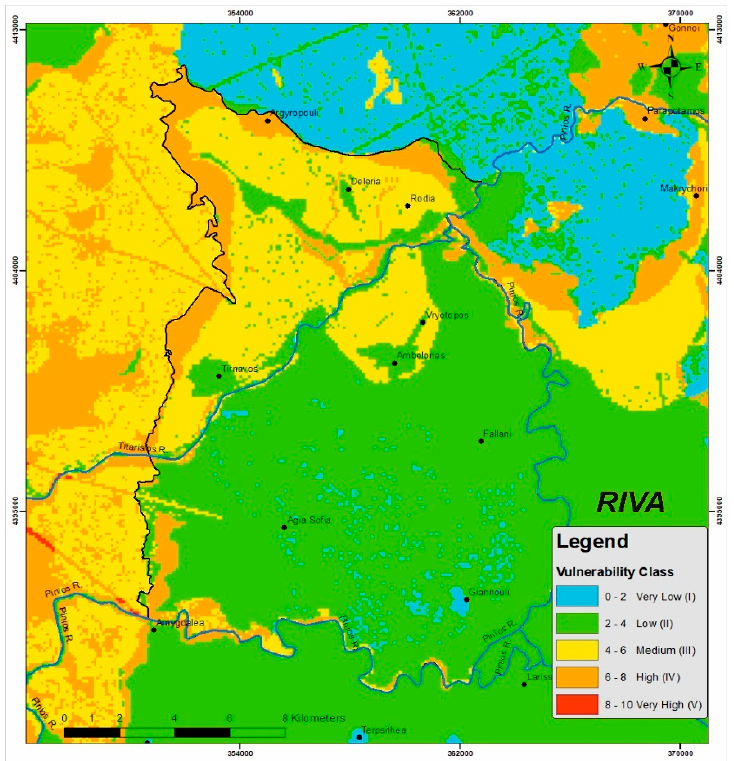
Figure 9. Spatial distribution of vulnerability classes according to RIVA method in the study area.